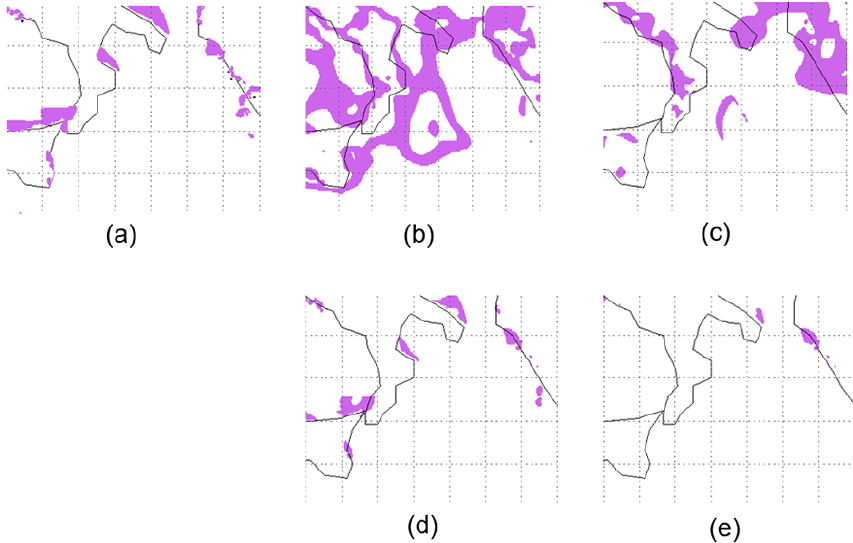
Figure 3. Selection operator: sample areas matching the conditions during selection (a–c) and intersection (d, e) operations.